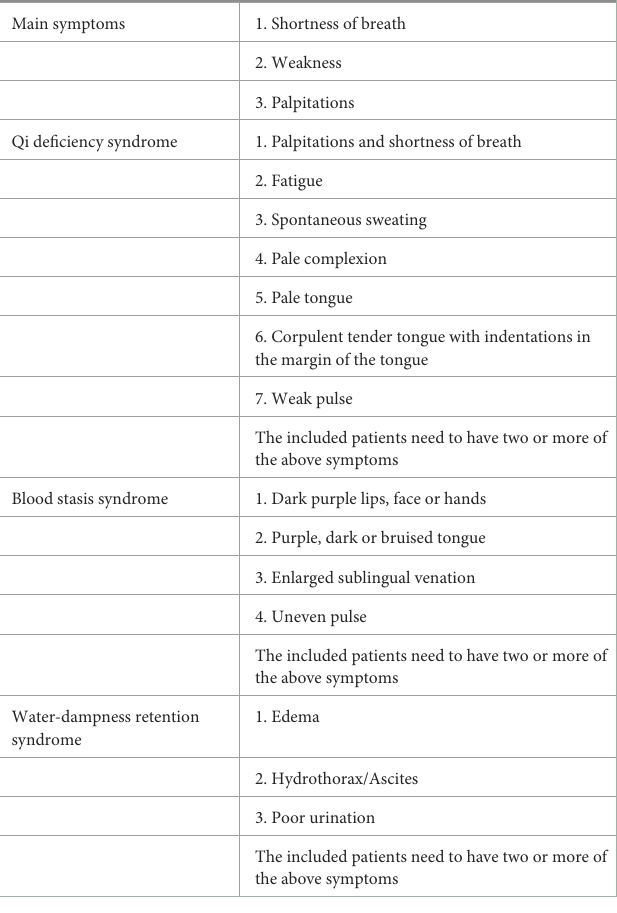
TABLE 3 Diagnostic criteria for traditional Chinese medicine syndromes. Qi deficiency and blood stasis and water-dampness retention (QBWD) Main